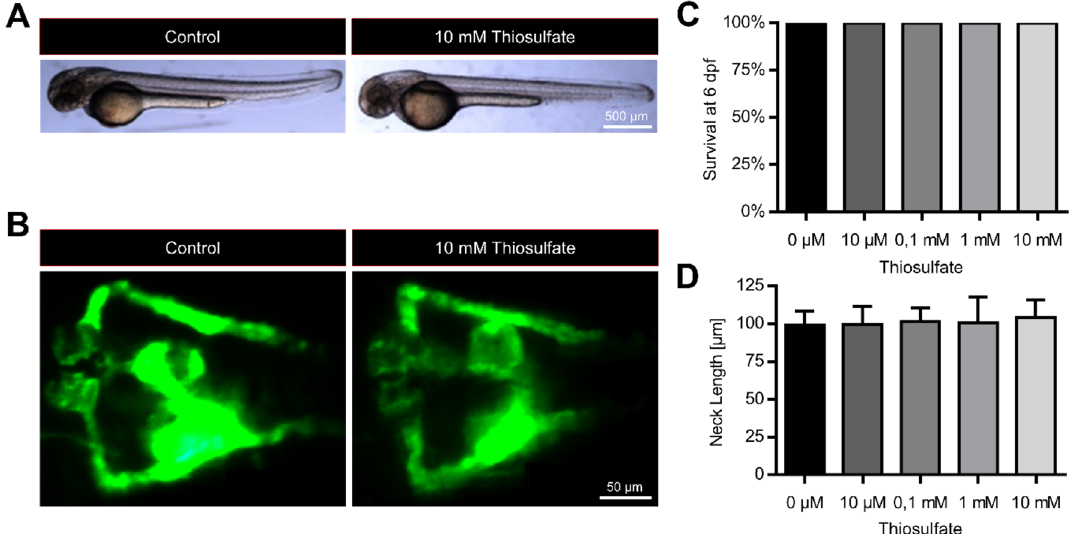
Figure 1. Thiosulfate exposure does not affect viability or pronephros morphology in healthy zebrafish larvae. ( A ) Representative overview of the zebrafish appearance at 48 hpf with and without 10 mM thiosulfate. Zebrafish embryos exposed to 10 mM thiosulfate did not show any gross morphological changes compared to controls. ( B ) Representative visualization of the pronephros phenotype in Tg(wt1b:EGFP) embryos at 48 hpf with and without 10 mM thiosulfate. Thiosulfate did not have any visible effect on the pronephros morphology compared to controls. ( C ) Evaluation of the survival in zebrafish larvae exposed to thiosulfate for 6